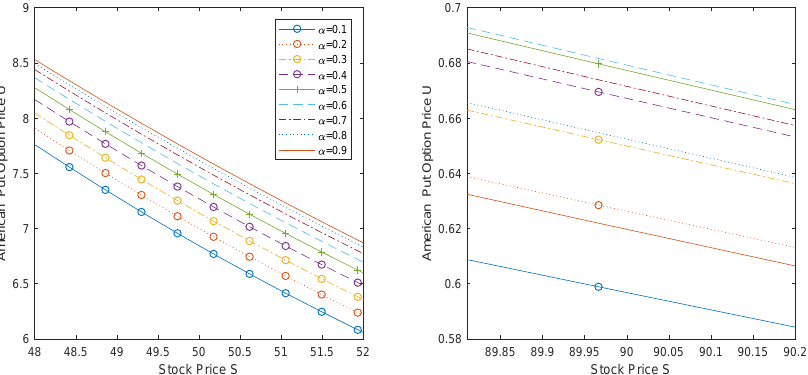
Figure 4. American put option prices at the terminal time T with M = N = 200 for different α